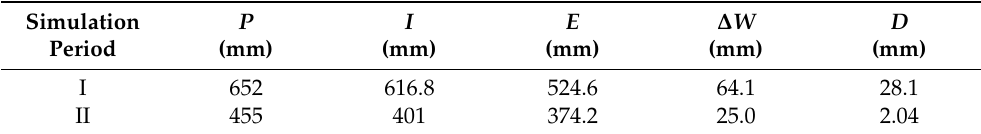
Table 3. The water balance on the plot scale during the modelling period.